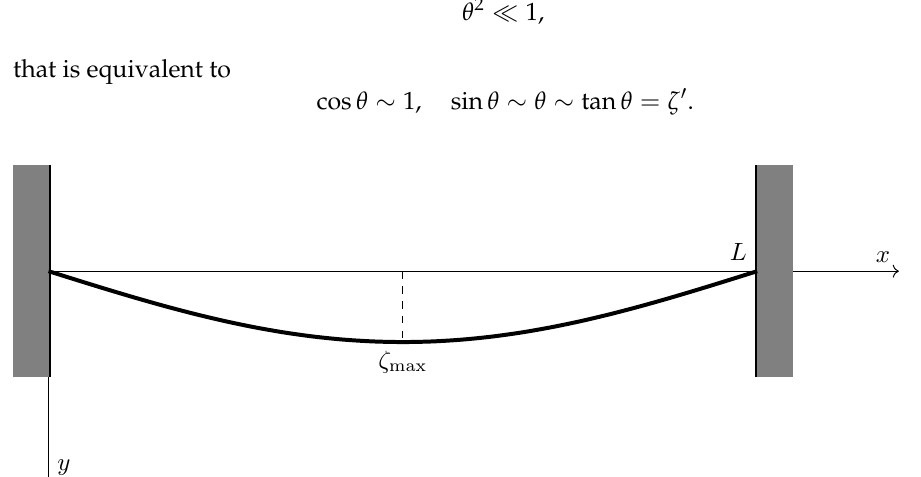
Figure 1. A linear deflection is defined by a small slope and implies that the maximum deflection is small compared with the distance between the supports.